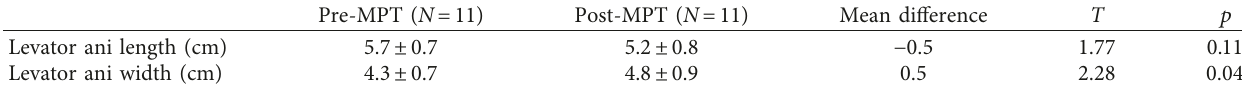
Table 3: Anatomical structural differences before and after MPT.